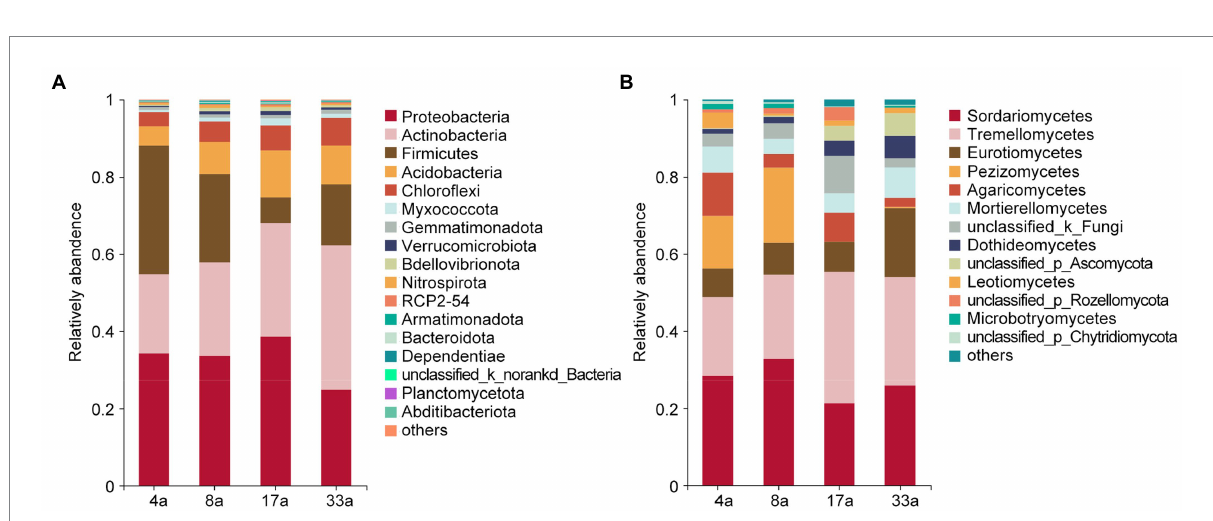
FIGURE 2 The relative abundance of major bacterial (phylum level; A ) and fungal (class level; B ) taxa present in the rhizosphere of blueberry at different